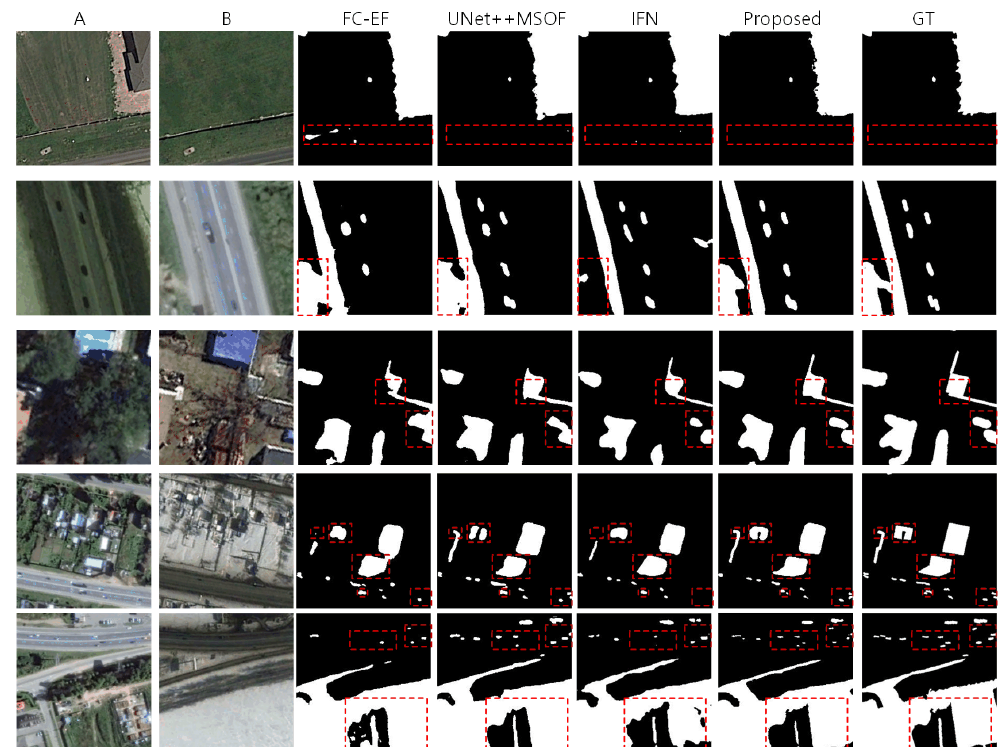
Figure 9. Qualitative comparison between our proposed BA 2 Net with other benchmark SOTA methods. Five rows are five sets of ‘ I t 1 , I t 2 , FC-EF, UNet++MSOF, IFN, BA 2 Net’, arranging the samples are becoming more and more challenging. The bi-temporal images in the first two rows are samples with multiple small regions changing and enclosing walls, land surface changes. These samples are not quite challenging pairs. Both SOTA and proposed maps perform well, but there are missing detection and false alarms in the SOTA maps, highlighted by the red boxes, while our model labeling correctly. The third sample is more challenging due to the region covered by seasonal appearance changes of trees. Our model is more accurate when representing the changes in the above challenging regions. The fourth and fifth samples contain largely seasonal appearance changes, multiple areas with various shapes. In the highlighted boxes, our results outperform the SOTA maps from correctness of localization and the accuracy of boundary